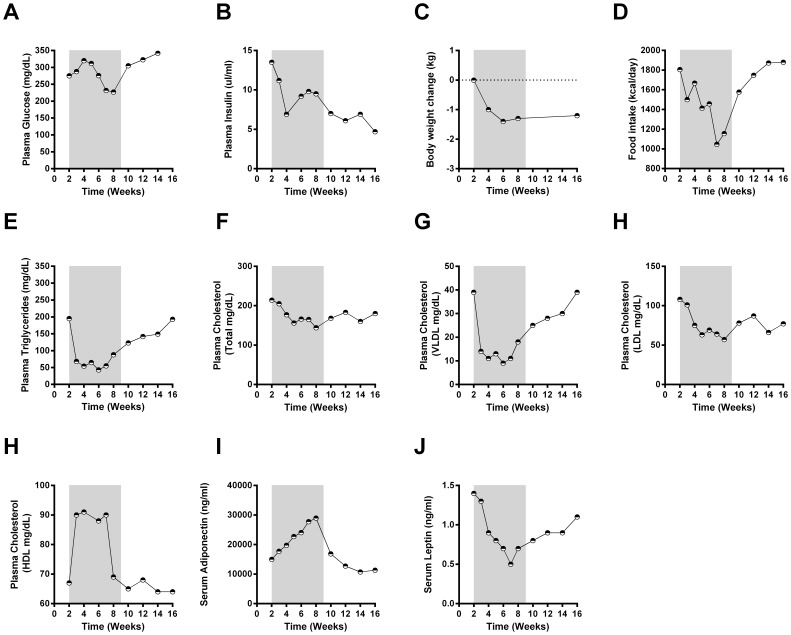
Data from J-15 are presented as a separate figure given more advanced disease state of this animal at study onset.As with the other animals we describe glucose (A) and insulin (B) in addition to body weight change (C), food intake (D) along with circulating levels of triglycerides (E), total cholesterol (F), VLDL cholesterol (G), LDL cholesterol (H) and HDL cholesterol (I). Furthermore, adiponectin (J) and leptin (K) were also determined. Differences considered significant (p<0.05) are denoted by *.